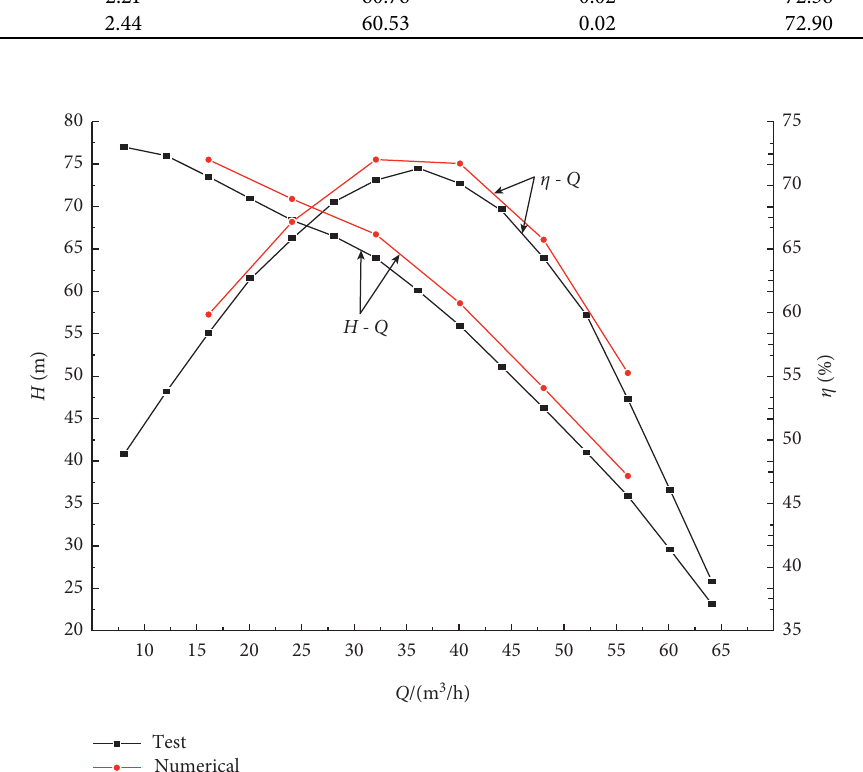
Figure 4: Comparison of the hydraulic performance between the numerical and test results.